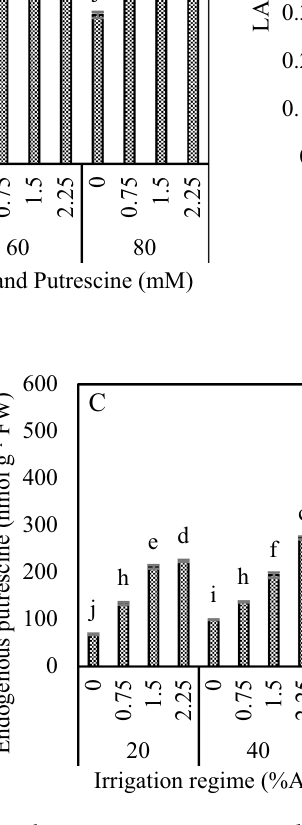
Figure 1. Interaction between irrigation regime and putrescine on RWC ( A ), LAI ( B ) and Endogenous putrescine ( C ). The different letters show significantly different at the level of 0.01. The error bars represent standard